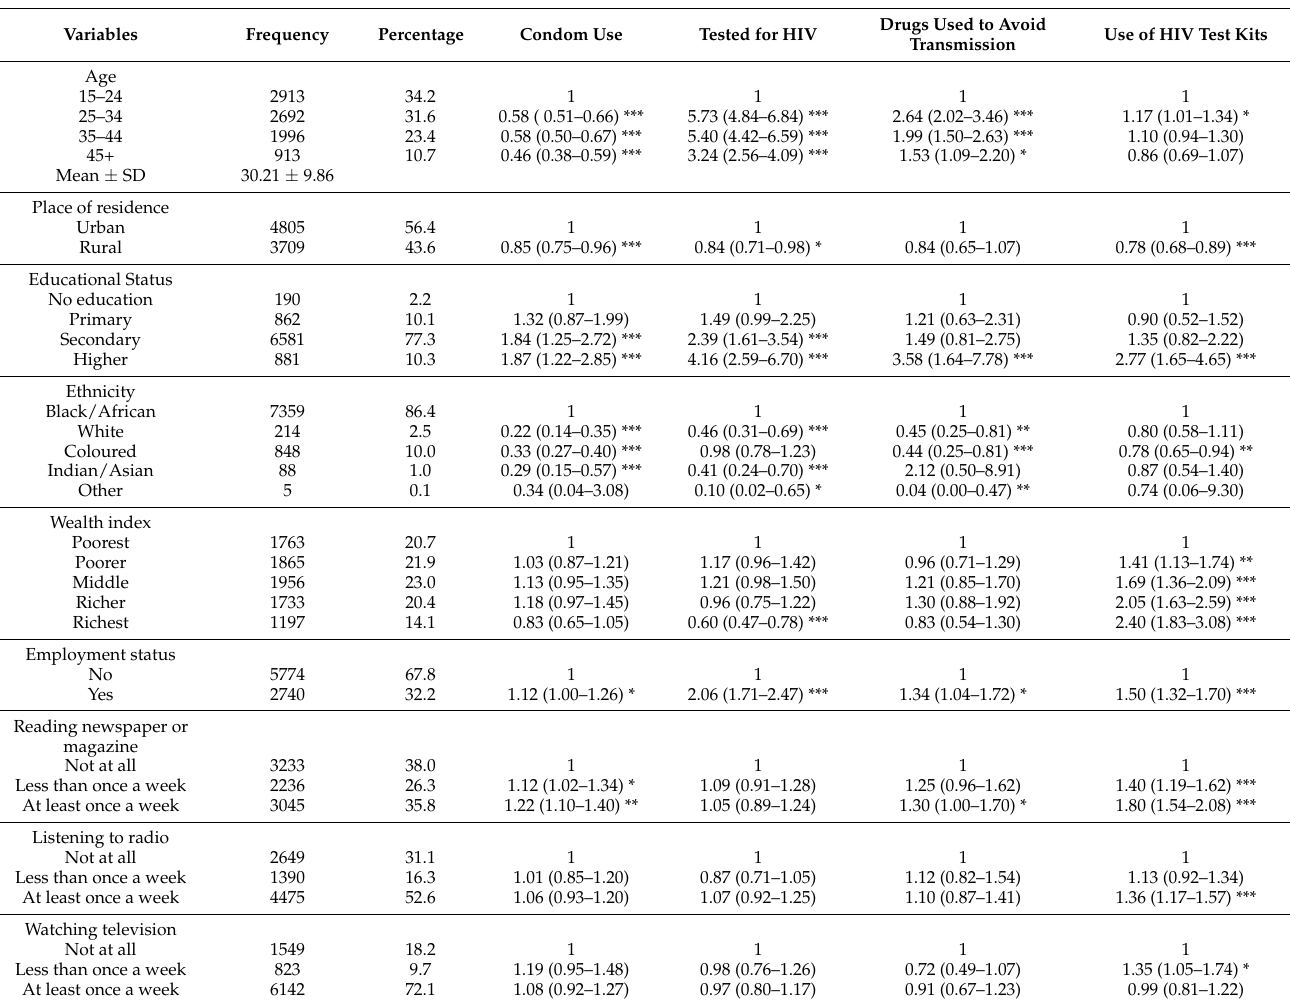
Table 1. Socio-demographic determinants of HIV prevention behavior among the women of South